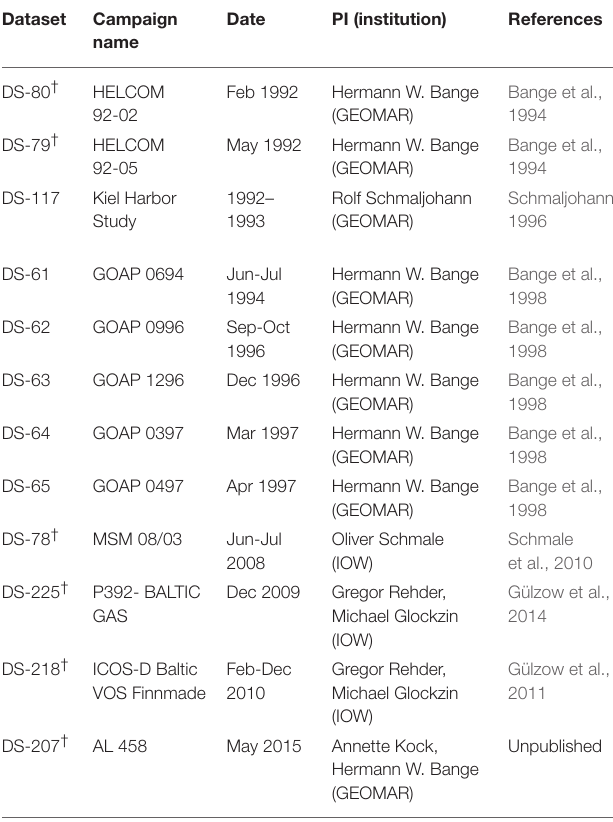
TABLE 1 | Datasets included in the MEMENTO database with data from the Baltic